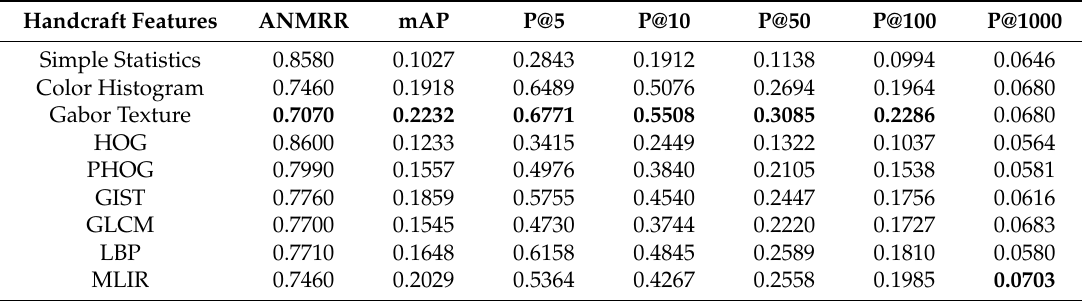
Table 3. Performance of single-label and multi-label RSIR based on handcrafted features. The bold values mean the best result for each performance